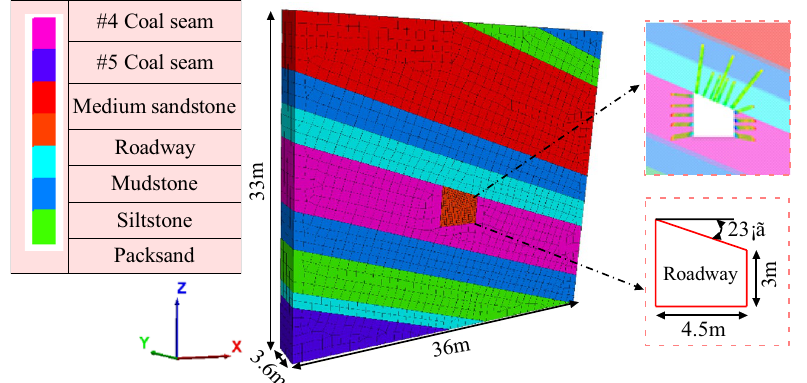
Figure 23. 3D computing model.